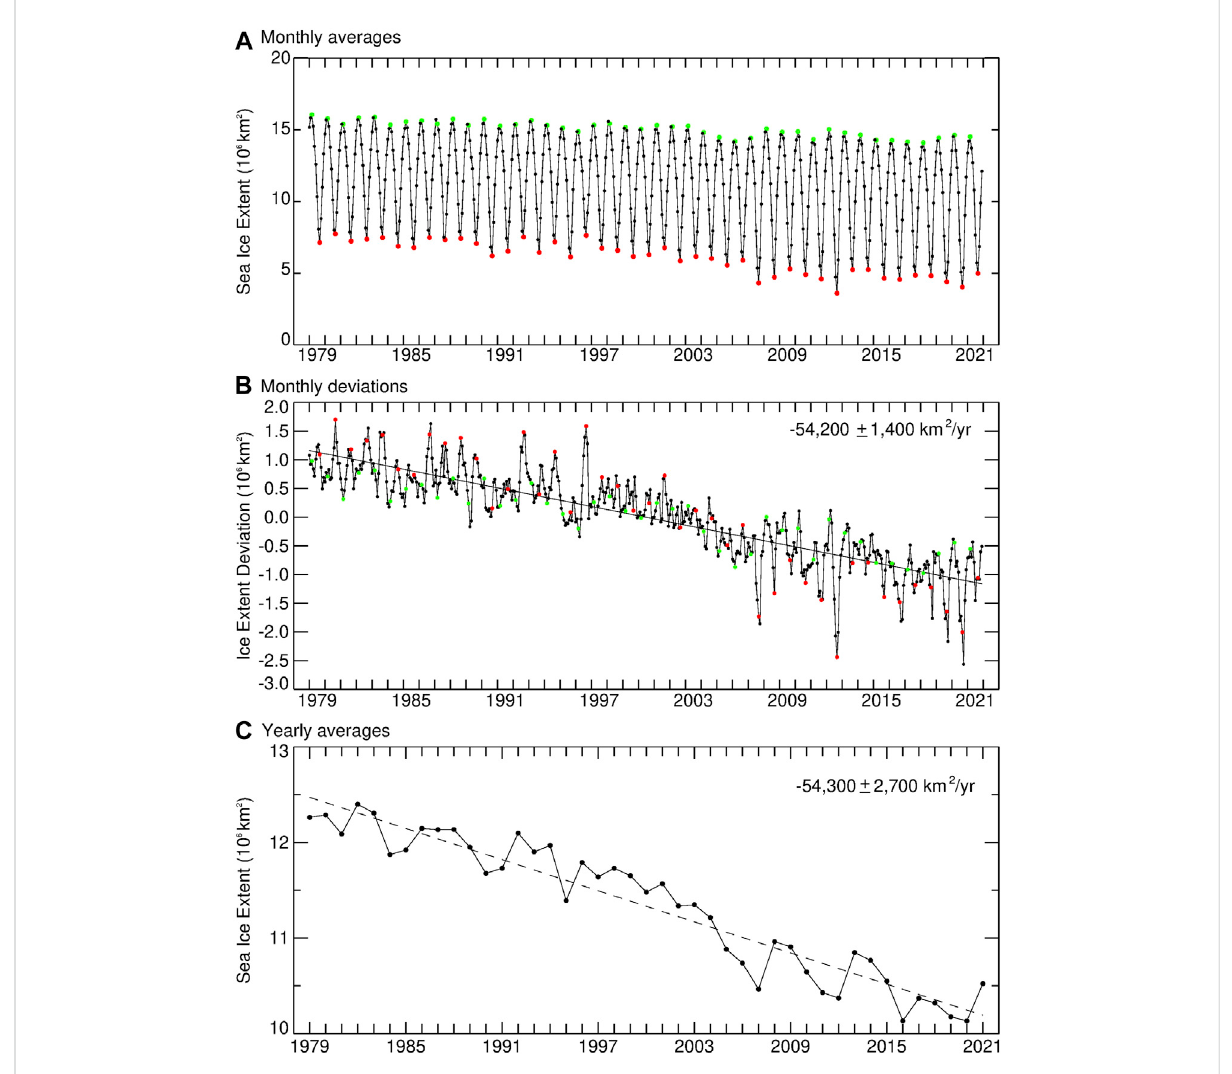
(Figure 1). The winter ice distributions re fl ect the importance of the Gulf Stream in bringing warm waters northeast across the North Atlantic, resulting in ice-free waters at quite high latitudes (70 – 75 ° N) immediately north of Norway (Figures 1A – C). In contrast, Hudson Bay remains covered with ice in late winter, despite its much lower latitudes (52 – 65 ° N), as a result of the continentality effect, wherein mid-continent locations tend to have colder winters and hotter summers than coastal locations affected by the moderating effect of the oceans (Figures 1A –